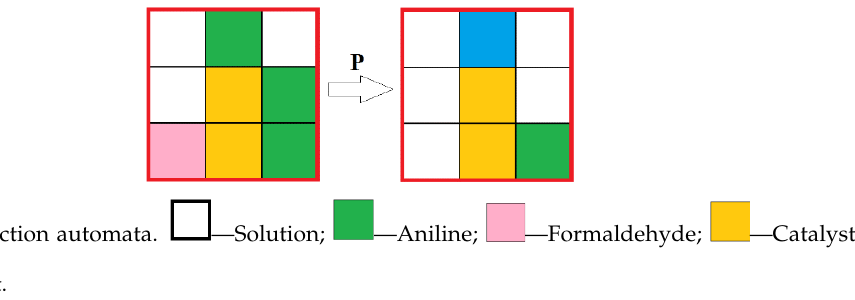
Figure 7. Reaction automata. —Product.